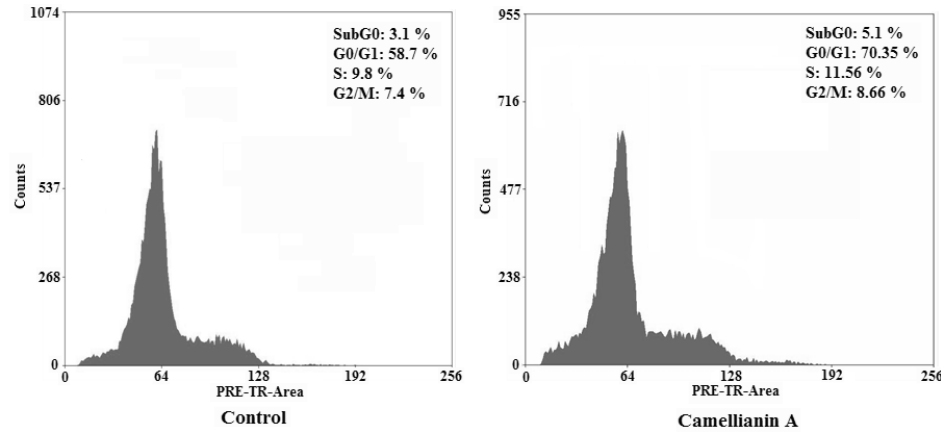
Figure 6. Effect of camellianin A on cell cycle distribution in MCF-7